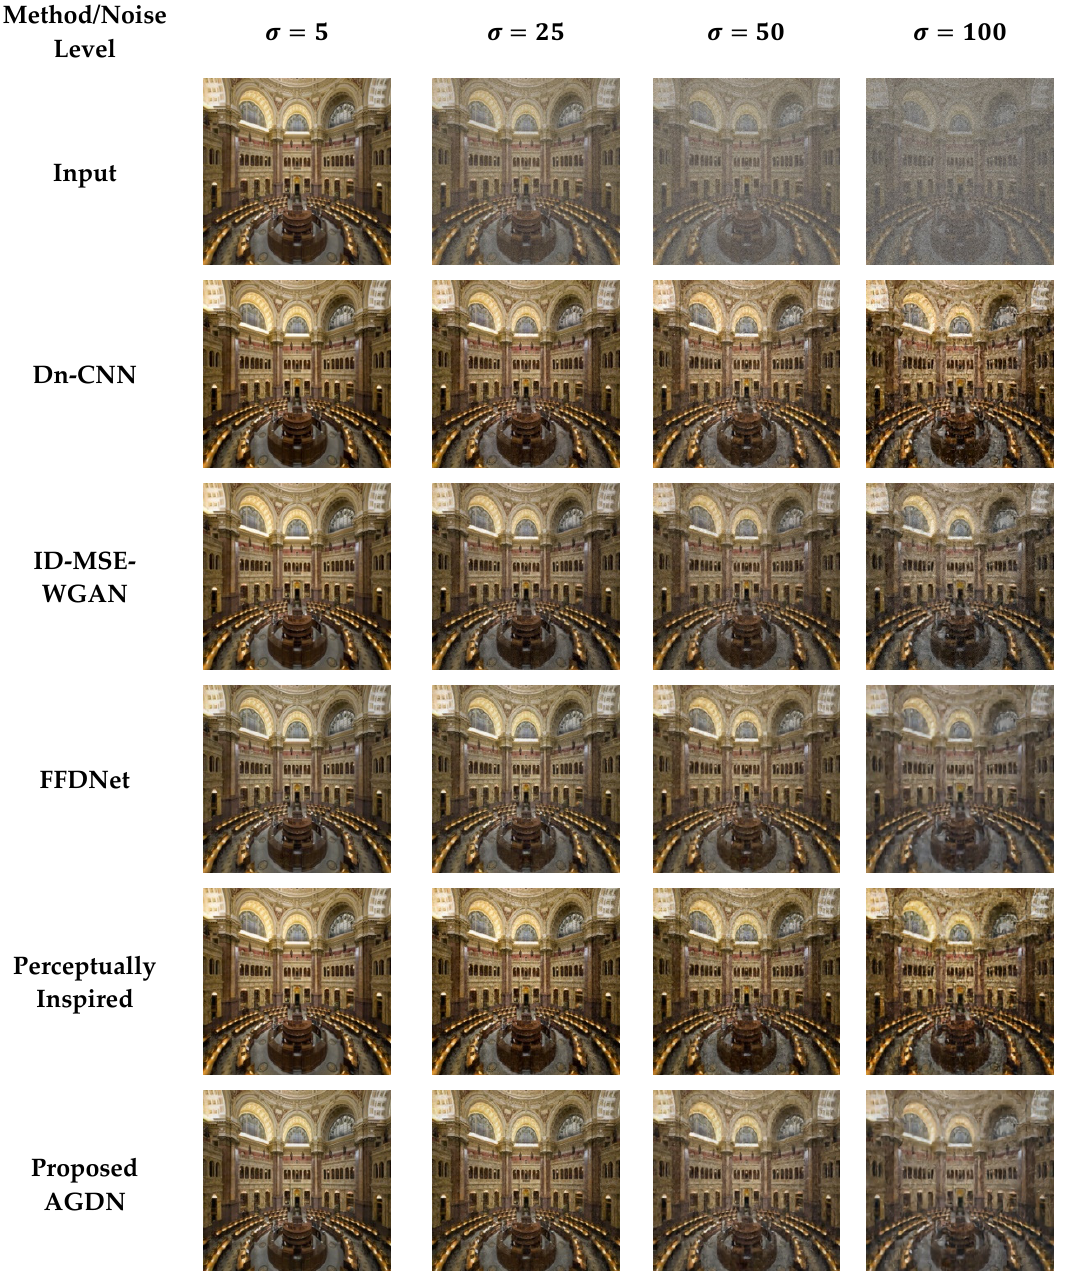
Figure 13. Third example results of image denoising tasks on the DIV2K dataset. The first to last column images generated by the noise level of sigma 5, 25, 50, and 100, respectively. First-row shows input images, second-row to the last row presents the results of Dn-CNN, ID-MSE-WGAN, FFDNet, the perceptually inspired method, and the proposed AGDN, respectively.